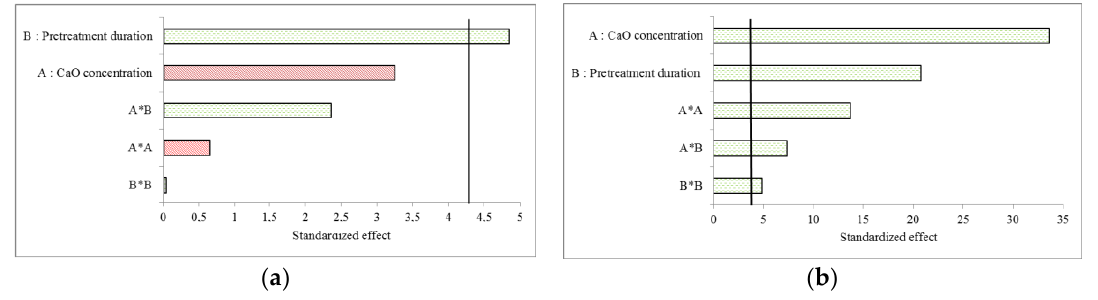
Figure 1. Pareto diagram showing the effect of different coefficient terms on BMP ( a ) and kinetics constant k ( b ) for Design 1. Red bars indicate a negative impact, and green bars show a positive impact. Bars exceeding the vertical line point to the significance of the coefficient terms ( p < 0.05, corresponding to 4.3 according to Student t-test in our conditions).